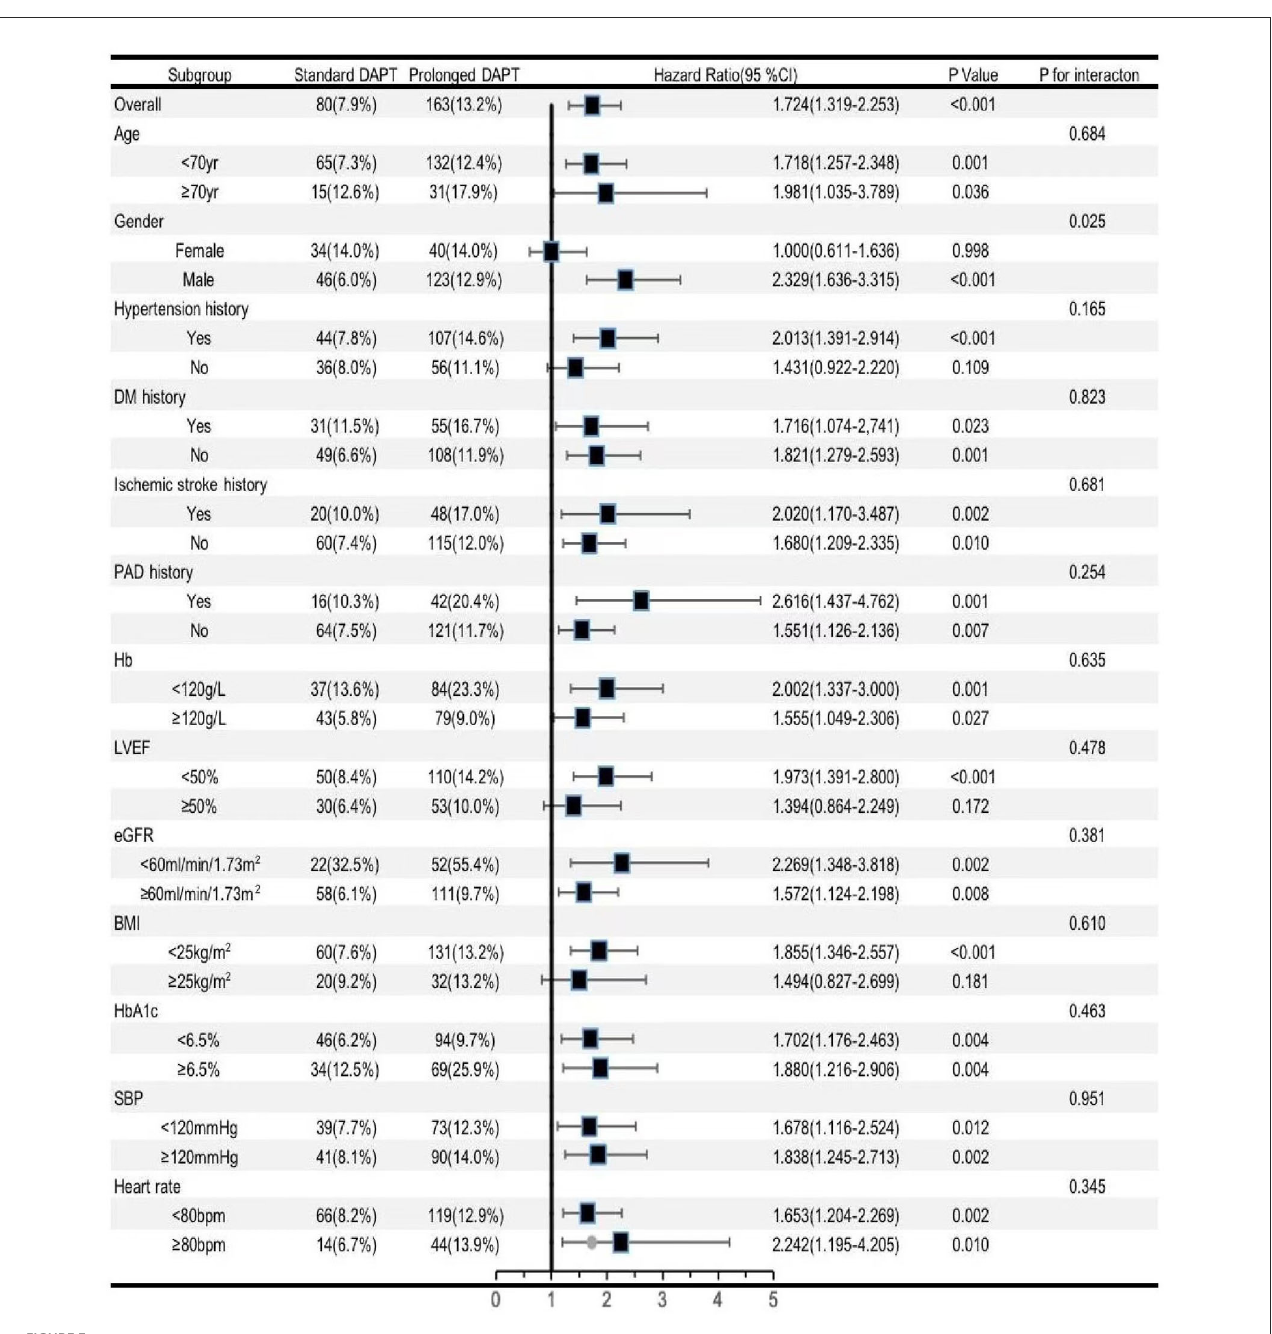
FIGURE3 Forest plot investigating th e association between the DA PT duration and composite bleeding events in different subgroups. DAPT, dual antiplatelet therapy; DM, diabetes mellitus; PAD, peripheral artery disease; Hb, hemoglobin; LVEF, left ventricular ejection fraction; eGFR, estimated glomerular filtration rate; BMI, body mass index; HbA1c, glycosylated hemoglobin A1c; SEP, systolic blood pressure; Cl, confidence interval.